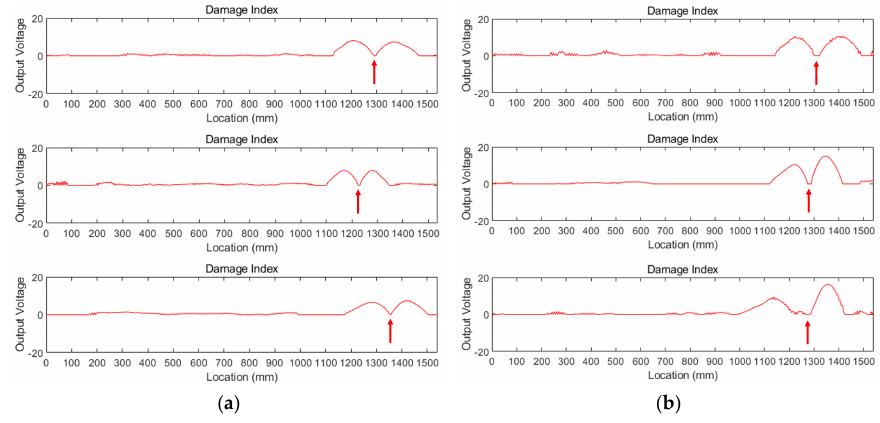
Figure 10. Damage index using denoised signals with: ( a ) 2.86% sectional loss; ( b ) 5.71% sectional loss.